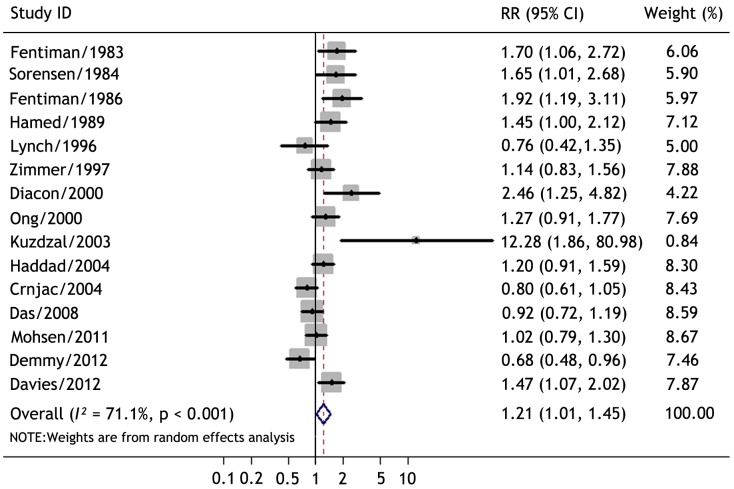
Meta-analysis of the relative risks (RR) of success rate between talc pleurodesis and control therapies using random-effects model.Bars represent 95% confidence intervals (CI) of RR in patients receiving talc pleurodesis versus controls. The center of the lozenge gives the combined RR. RR was considered statistically significant if the 95% CI for the overall RR does not overlap one.